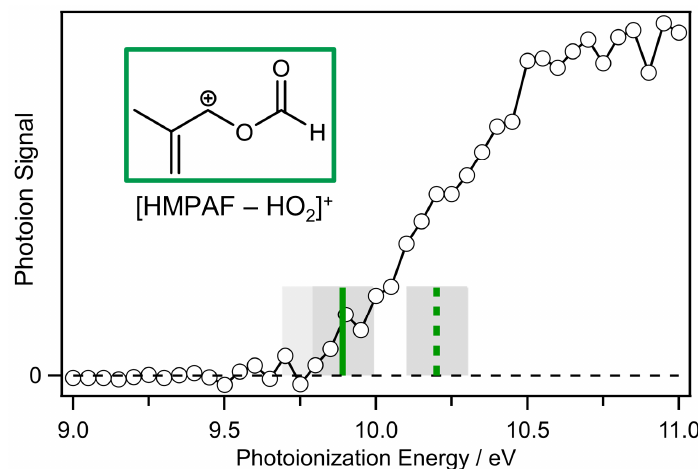
Figure 5. Photoionization spectrum of m/z 99 obtained upon introduction of formic acid (2.6 × 10 13 cm −3 ) and integration over the full kinetic time window (0–60 ms) with calculated appearance energy of the HMPAF–HO 2 fragment ion (green solid line) and vertical ionization energy of HPMAF (green dashed line). The grey shaded region represents uncertainty associated with the calculated ionization energies (± 0.1 eV). The light grey shaded region represents the appearance energy of higher energy conformers of HPMAF.